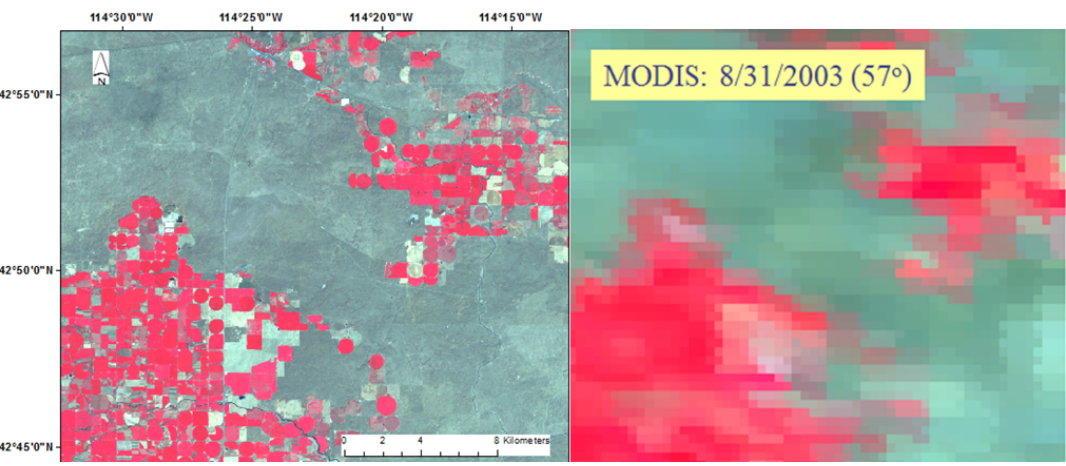
Figure 3. (Left ) Landsat image (combination 4,3,2) for 08/31/2003 near Minidoka, southern Idaho. ( Right ) MODIS-Terra image (2,1,4) for the same day, taken at 57° sensor view angle, showing substantial pixel deformation and